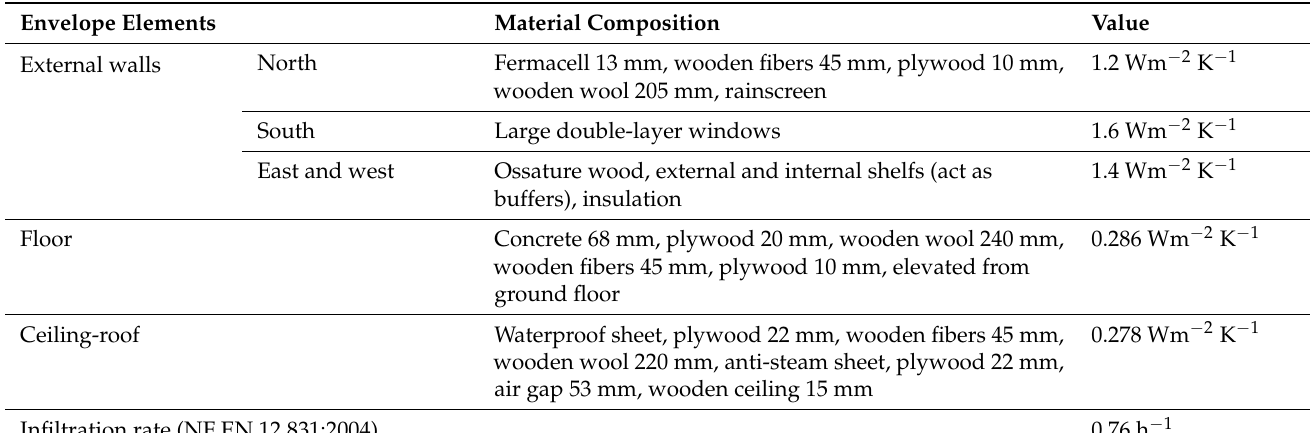
Table 1. Summary of the physical characteristics of the envelope elements.